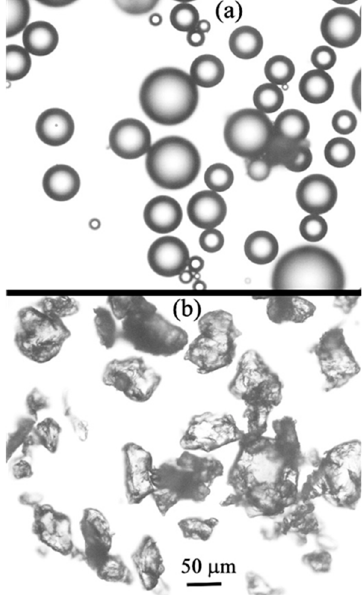
Figure 2. Appearances of acrylic ( a ) and PTFE ( b ) particles.